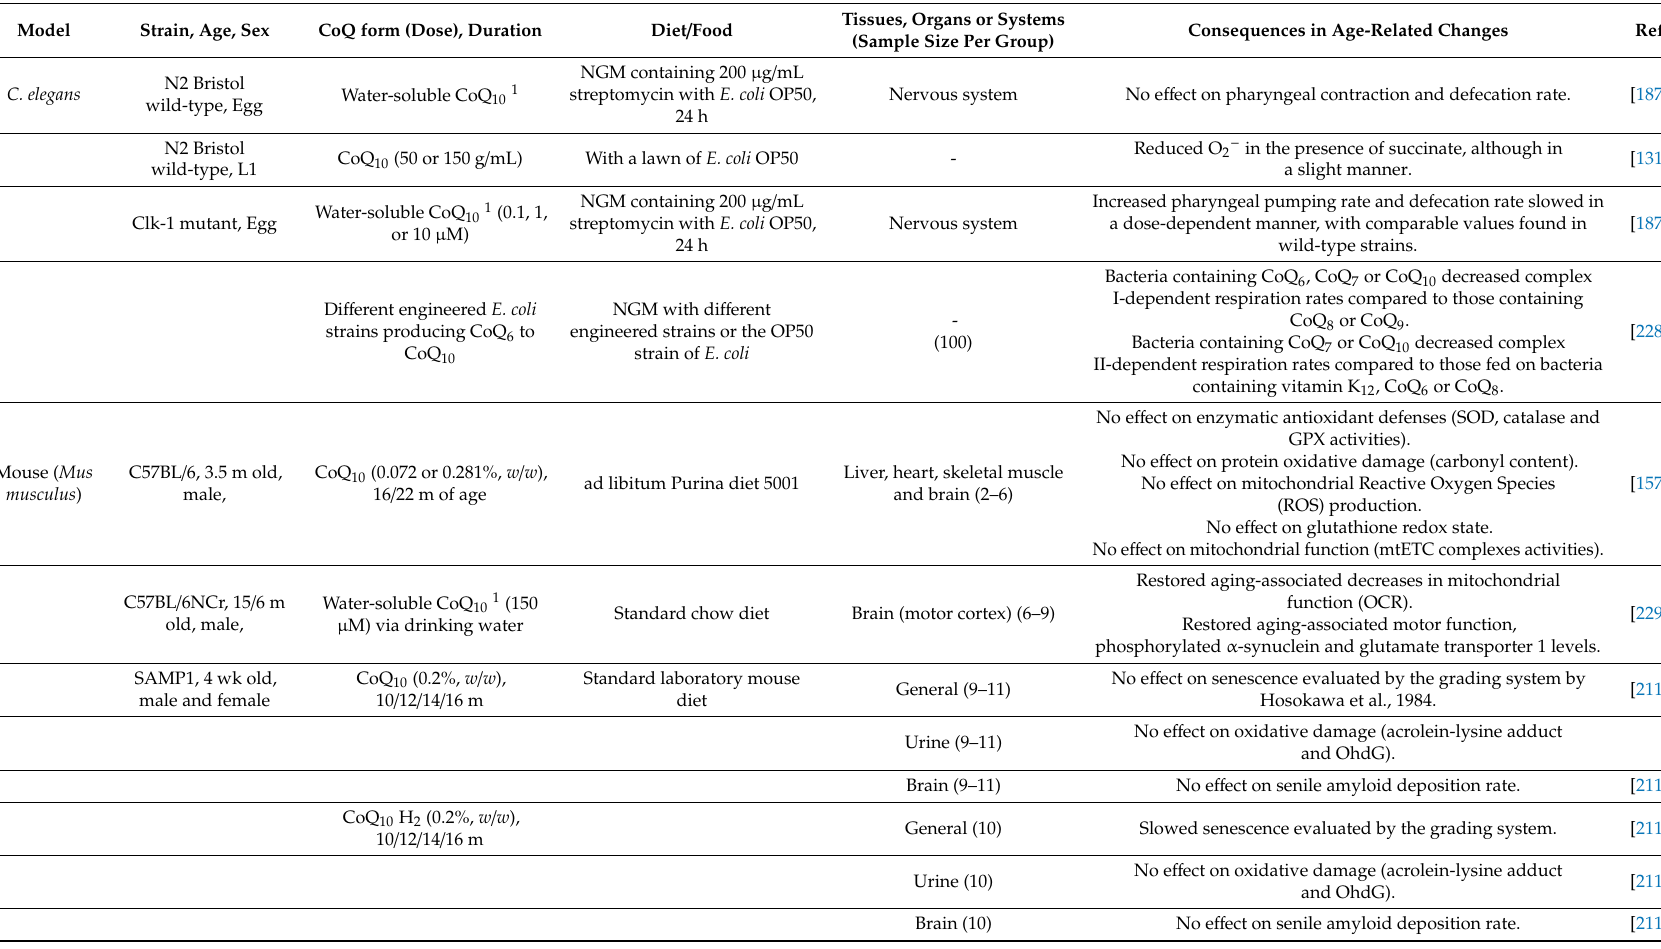
Table 2. Studies on long-term coenzyme CoQ treatment e ff ects on age-related changes in disease-free animal